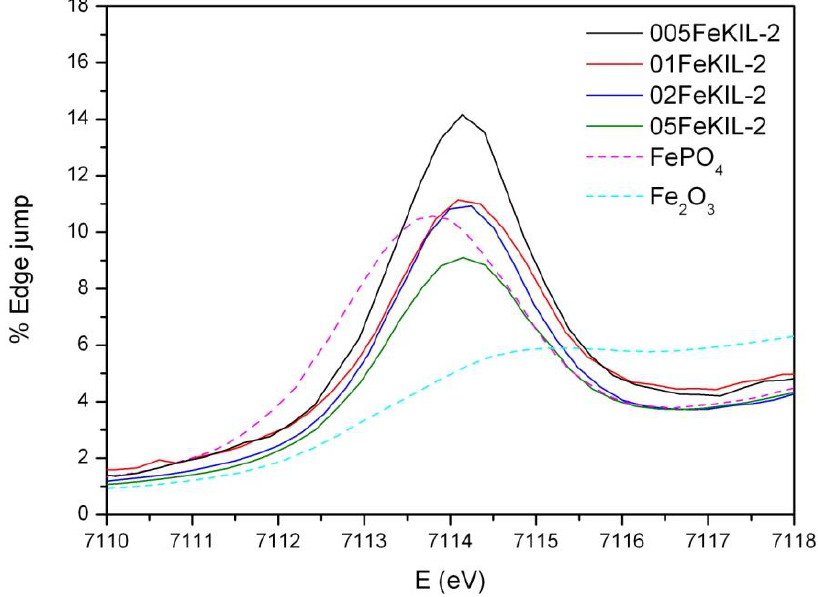
Figure 5. Fe K-edge X-ray absorption spectra of the FeKIL samples and reference compounds of the pre-edge region. A comparison of the heights and shapes of the pre-edge resonances.